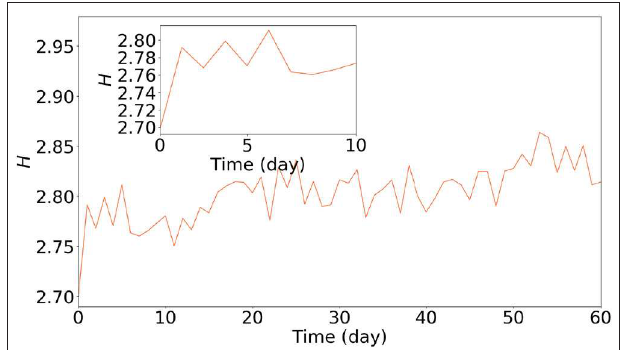
FIGURE 3 | Entropy evolution of the stock network during the 60-day period following the crash on 10 March 2015 in the Hong Kong stock